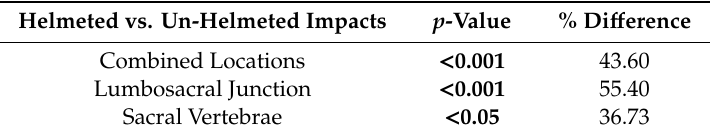
Table 4. Helmeted vs. un-helmeted peak load comparisons for both combined and individual impact locations. p -Values in bold indicate statistically significant di ff erences. Note: These values are calculated using un-helmeted data from horse 2 only as this was the horse used for helmeted impacts.